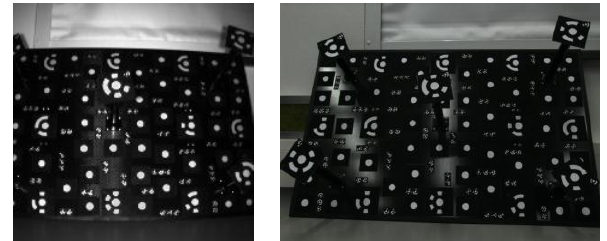
Figure 5. Calibration image for PMD camera (left) and RGB camera (right)